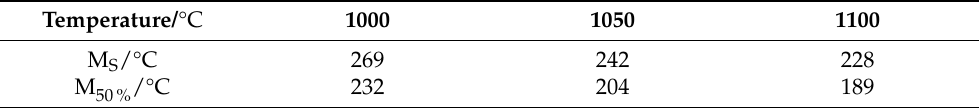
and M 50% is the temperature at which 50% of martensite has